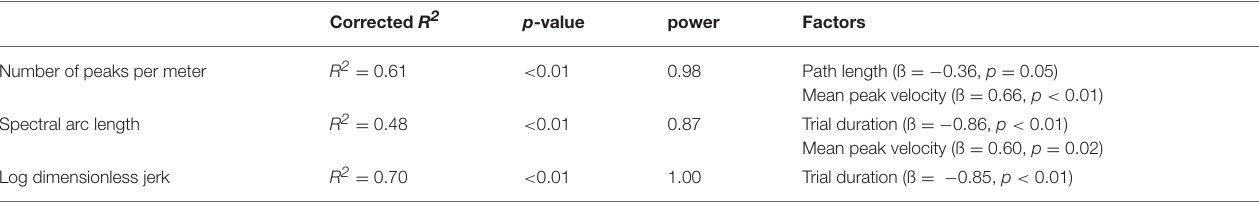
TABLE 4 | The corrected R 2 -values of models of multiple linear regression, their p-values, power estimates, and the models’ factors for three of the four smoothness parameters.